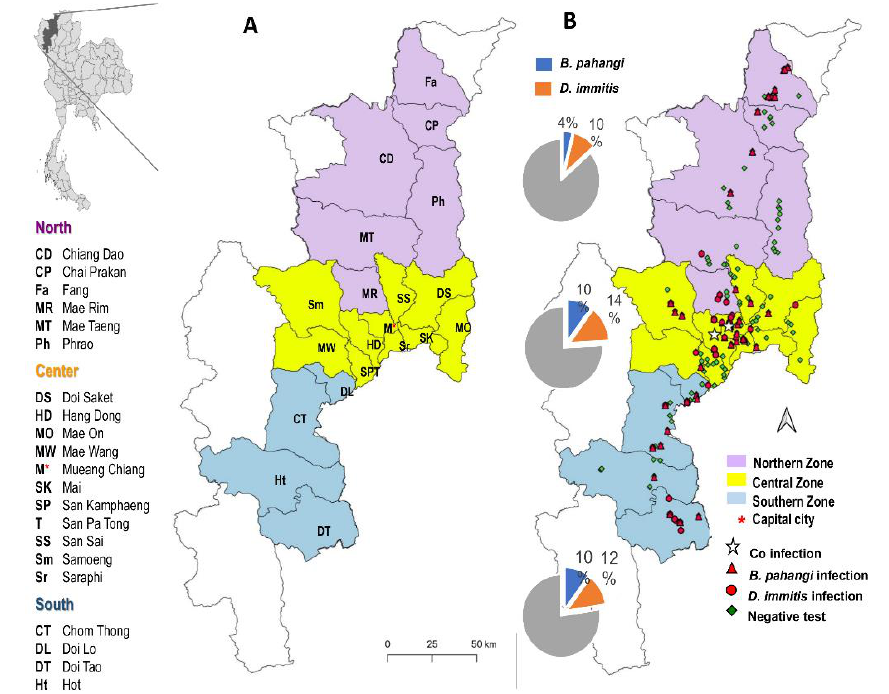
Figure 1. Study sites and geographic distribution of canine filariasis in three zones of Chiang Mai, Thailand. ( A ). The study districts; ( B ). Distribution of Brugia pahangi and Dirofilaria immitis positives and the proportion of prevalence of filarial nematode species in each zone .